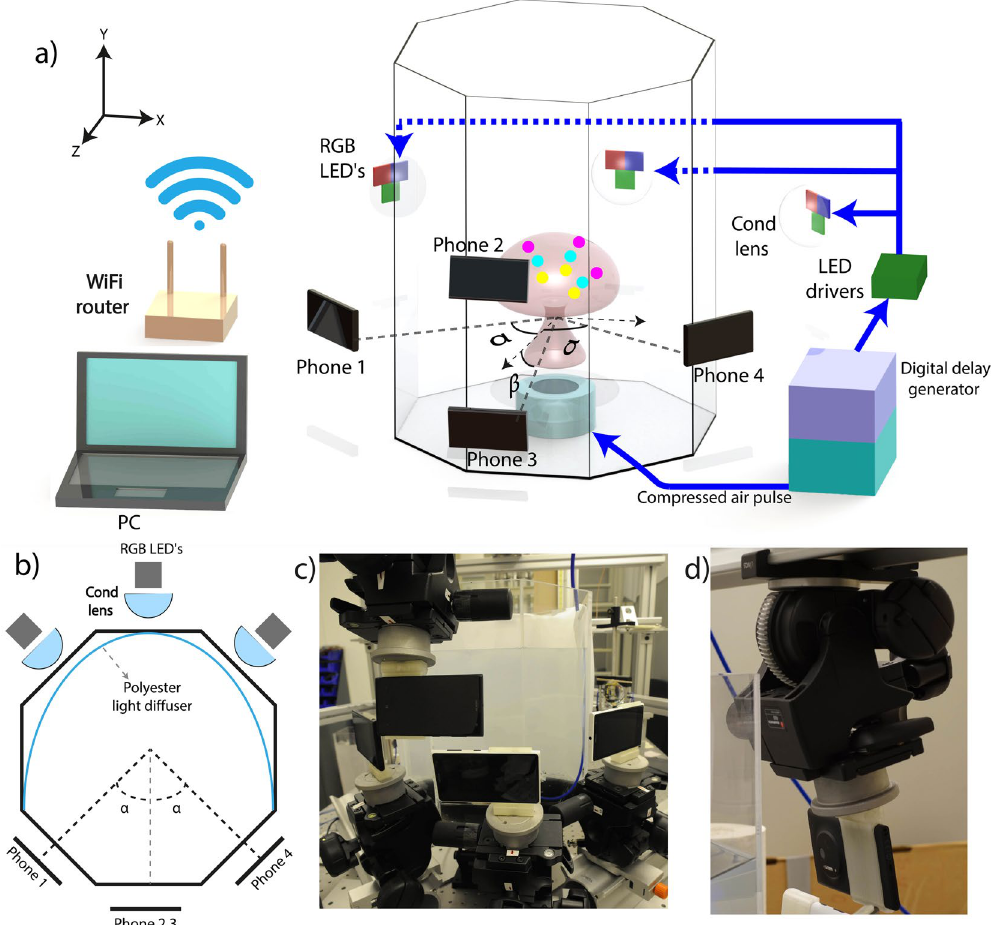
Figure 1. ( a ) Schematic experimental setup of the smartphones, vortex ring generator, LEDs and the components required to trigger and synchronize the system, while capturing three different time steps shown as yellow, cyan and magenta colors. The angle between the cameras are α = 45° and β = 10°. ( b ) Top view of the setup. ( c ) Actual photography of the setup, showing the mounting structure for precise and fine adjustment of the smartphones. ( d ) Detail of the support structure and 3d printed